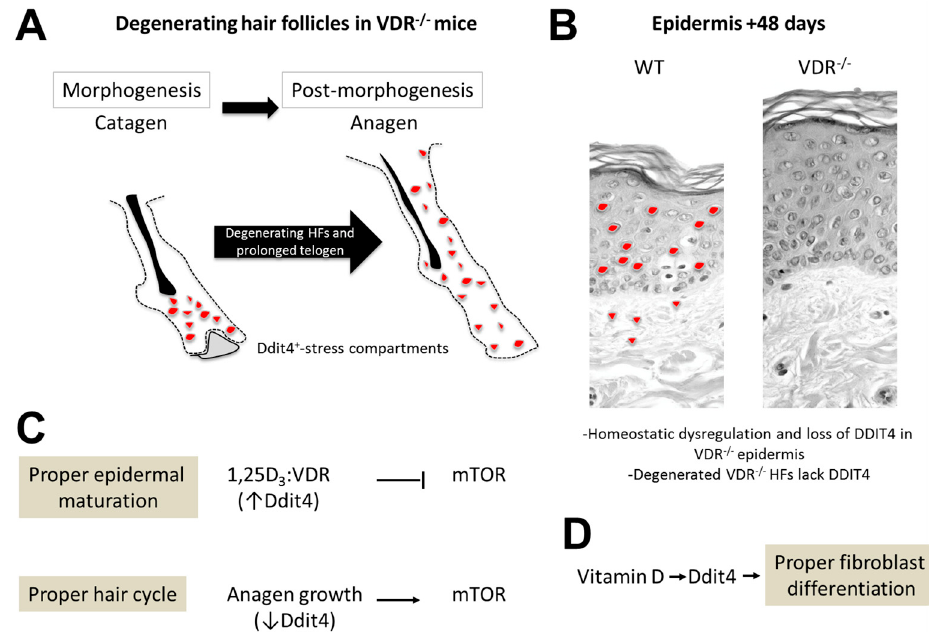
Figure 7. Early stress in VDR − / − hair follicles and epidermal regulation of Ddit4 by the VDR (column 1.5). Schema depicting the major findings. ( A ) VDR − / − hair follicles (HFs) exhibit DDIT4 + stress